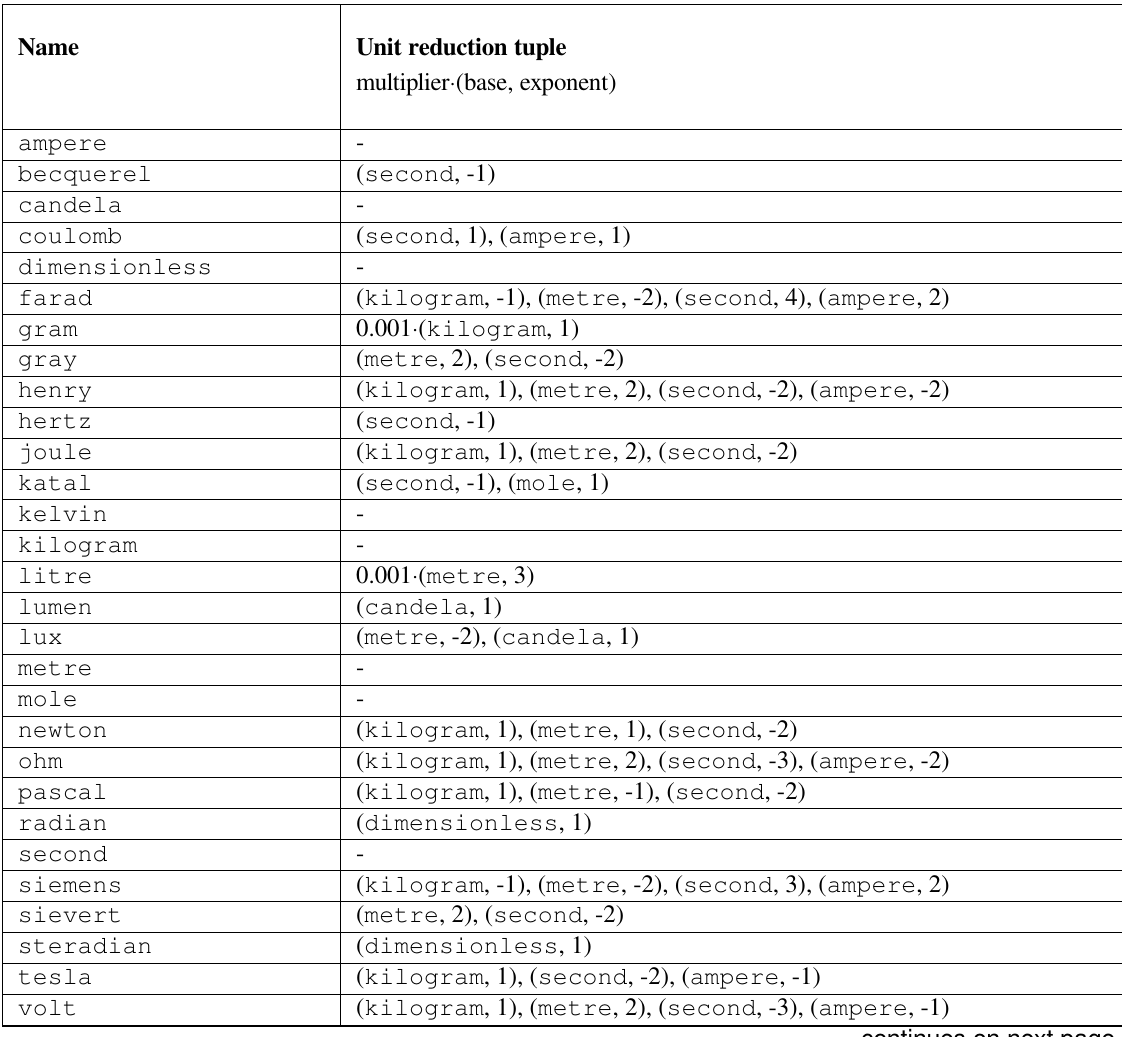
Table 3.1: Built-in